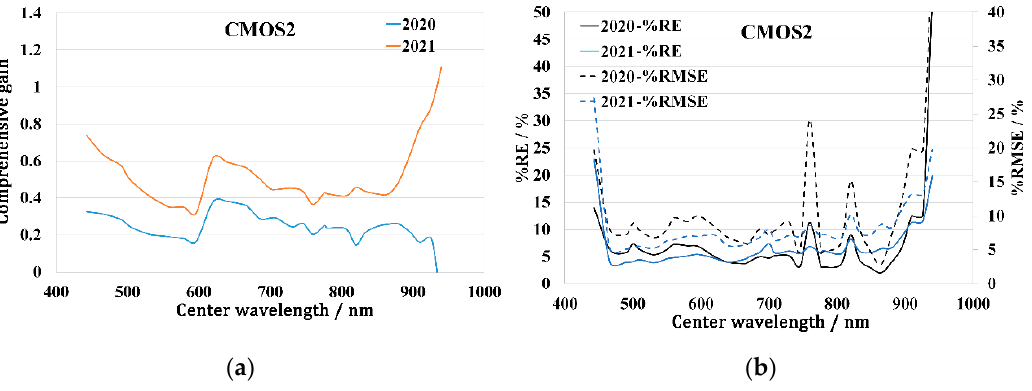
Figure 14. Comprehensive gain fitting results and fitting errors for OHS-F CMOS2. ( a ) Description of comprehensive gain fitting results; ( b ) description of comprehensive gain fitting error.